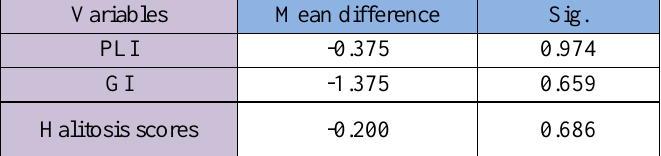
Table 3: Comparison by Scheffe test between the groups according to variables at baseline